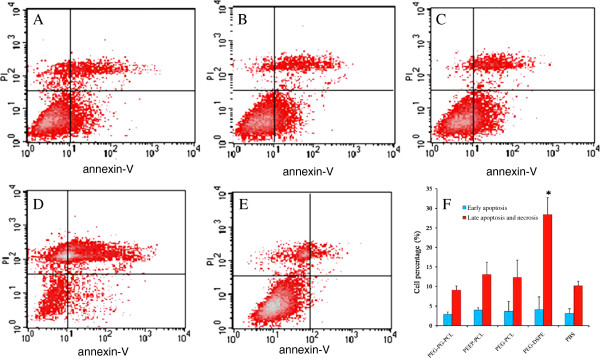
Apoptosis of Eahy.926 cells induced by PEG-PG-PCL (A), PEEP-PCL (B), PEG-PCL (C), PEG-DSPE (D) and PBS (E) after 24 h. (F) was the result of apoptotic cell percentage of triplicate tests reported as mean ± SD. *p < 0.01 vs. PBS control.